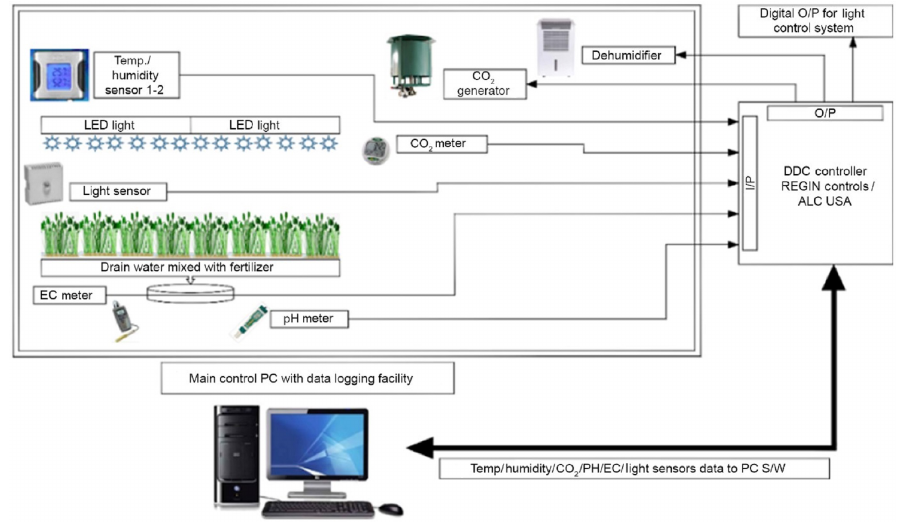
Figure 1. Experimental Setup for Climate Control System.